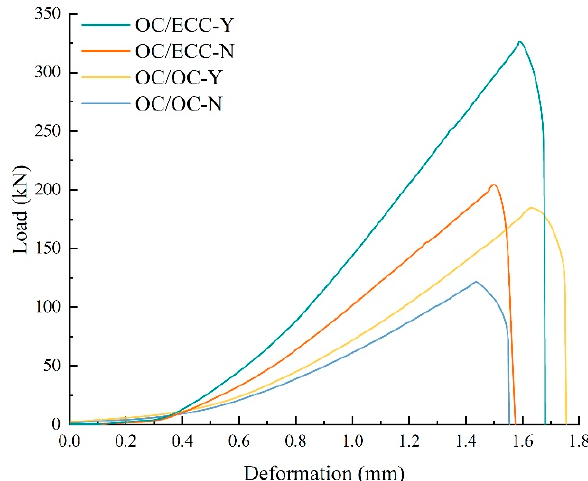
Figure 8. Load–deformation curve from the slant shear test.